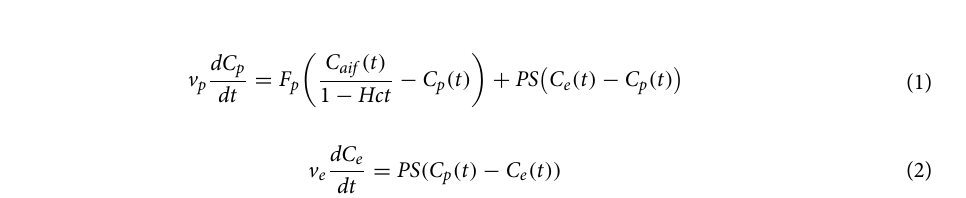
Figure 3. The (main-bolus) arterial input functions (AIFs) after Dixon MoCo for the three echo images with the T2* corrected AIF obtained through the fitting of the three echo AIFs to Eq.